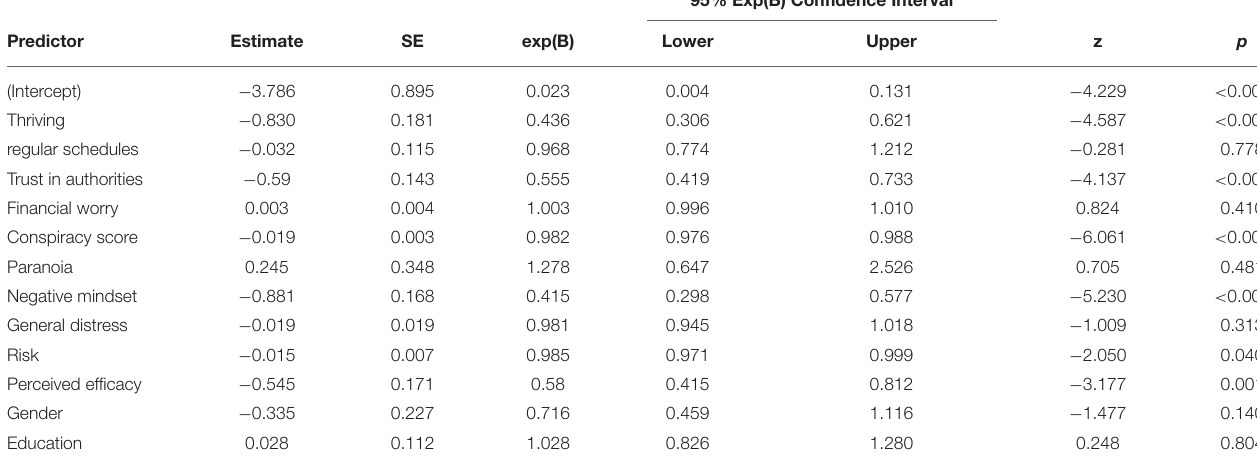
TABLE 4 | Fixed effects parameter estimates for